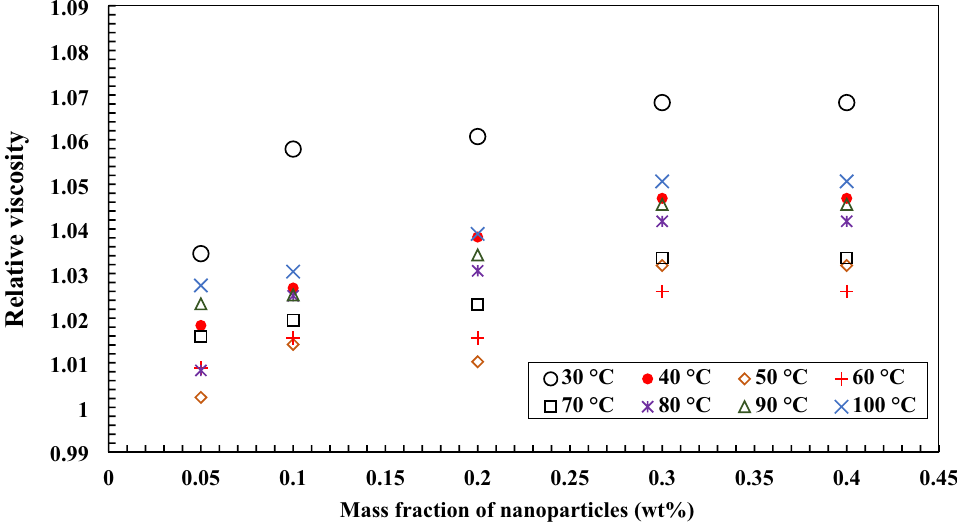
Figure 14. Variation of relative viscosity of TiO 2 /turbine meter nanofluids in different mass fraction.